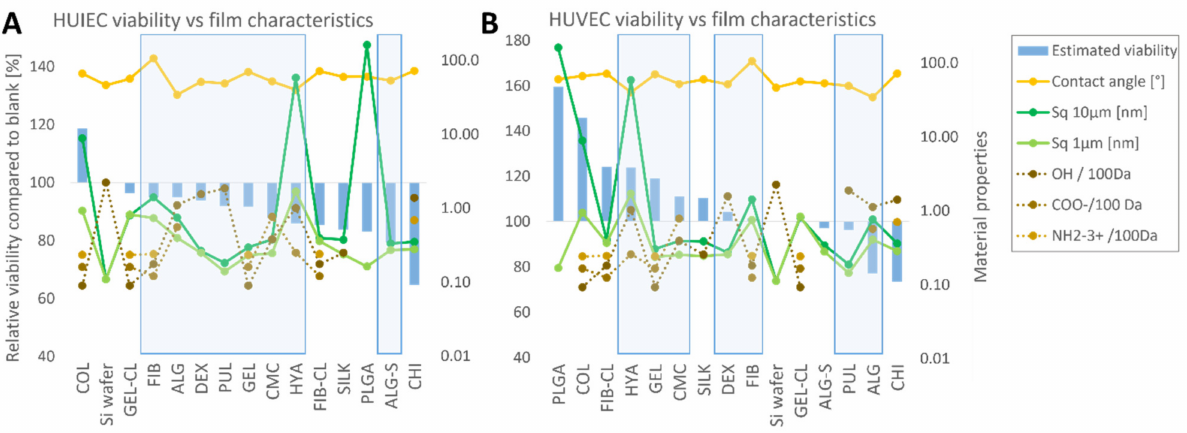
Figure 5. Estimated viability of HUIEC ( A ) and HUVEC ( B ) cells compared to thin-film characteristics. For improved legibility of the data, the values of the estimated viability were calculated by combining the results of the MTT assay and cell morphology into a biocompatibility score as shown in Figure 4 and further described in the Materials and Methods section. The estimated viability values are compared to thin-film characteristics (curves plotted against the secondary Y axis). The static water contact angle (yellow), roughness (green), and the number of functional groups (brown) are shown. Water-soluble polymers are marked with a blue